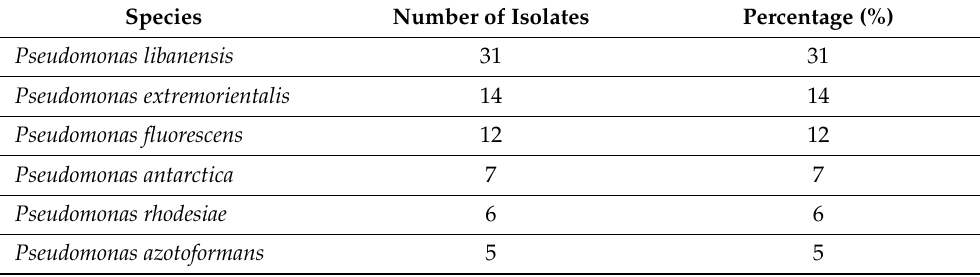
Table 2. Percentage and number of Pseudomonas spp. isolated from chromogenic agar for Pseudomonas in turkey